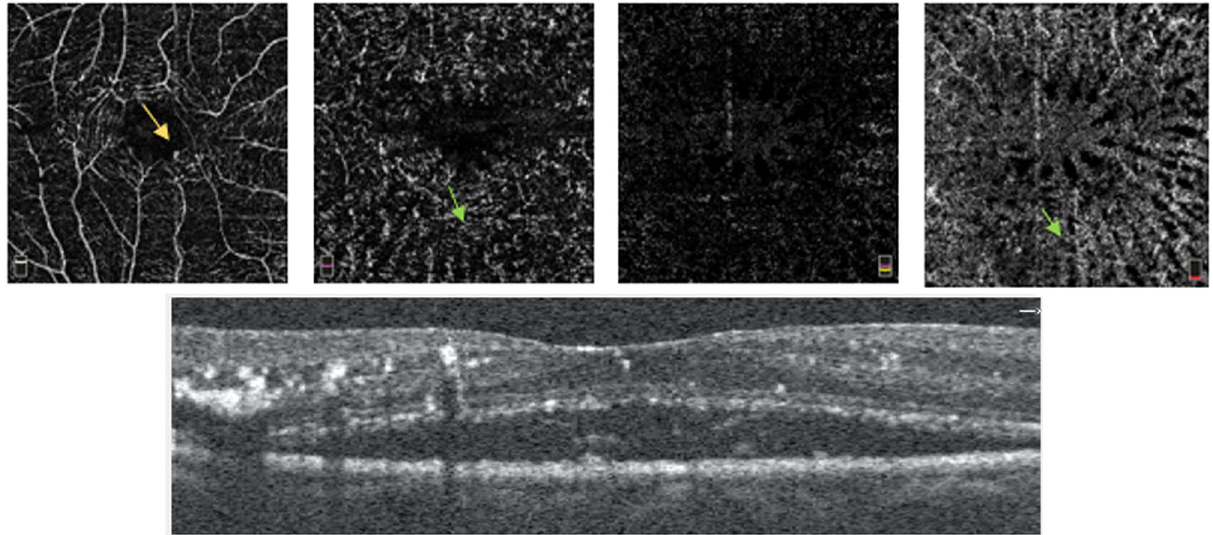
Figure 3. (Patient 24) OCTA: 3 mm × 3 mm section. SCP—Capillary rarefaction seen between larger vessels. FAZ maintained. Beading and aneurysmal dilatation of perifoveal vasculature (yellow arrow). DCP—Diffuse capillary rarefaction seen as radial darker stripes (green arrow) corresponding to retinal oedema in Henle’s layer. Areas of pruning noted in the smaller network of vessels. OR—Projection artifacts with darker radial lines continuing in the avascular layer. CC—Loss of the regular coarse architecture. A better appreciation of the darker radial striations corresponding to oedema in the Henle’s layer (green arrow). OCT showing mild intraretinal oedema and HRS and SRF with subretinal hyperreflectivity. OCTA Optical coherence tomography angiography. SCP Superficial capillary plexus, DCP Deep capillary plexus, OR Outer retina, CC Choriocapillaries, OCT Optical coherence tomography, FAZ Foveal avascular zone, HRS Hyperreflective